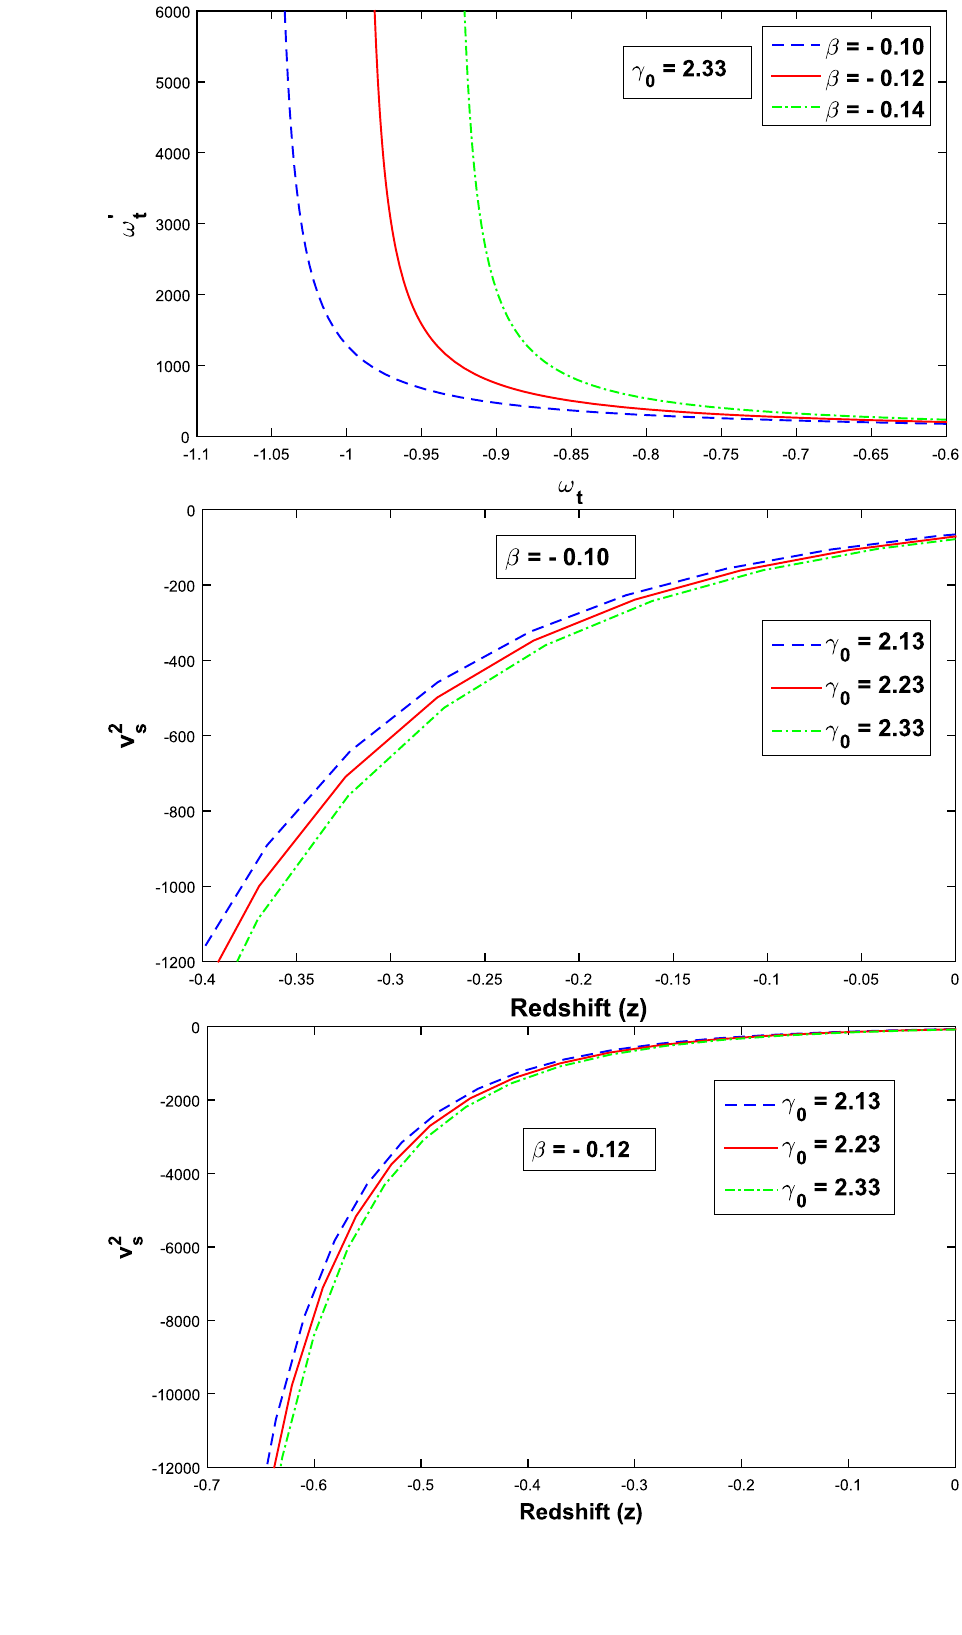
Fig. 14 Plot of squared sound speed ( v 2 s ) versus redshift ( z ) for c 1 = 0 . 01, c 2 = 0 . 115, k = 0 . 325, γ = 2 . 13 , 2 . 23 , 2 . 33, α = 1 . 5, 0 and β = − 0 .